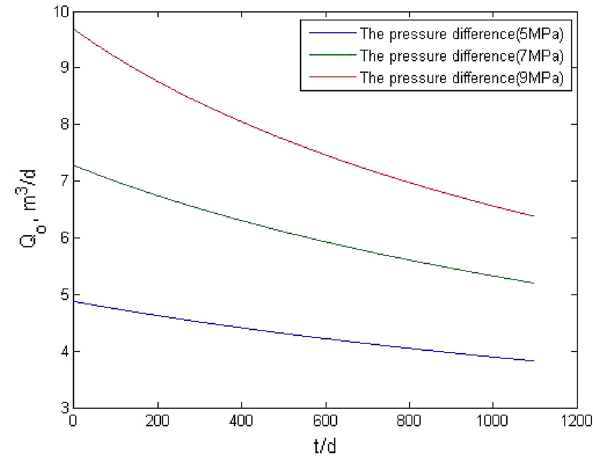
Fig. 10 Effects of pressure difference between injection well and pro- duction well on